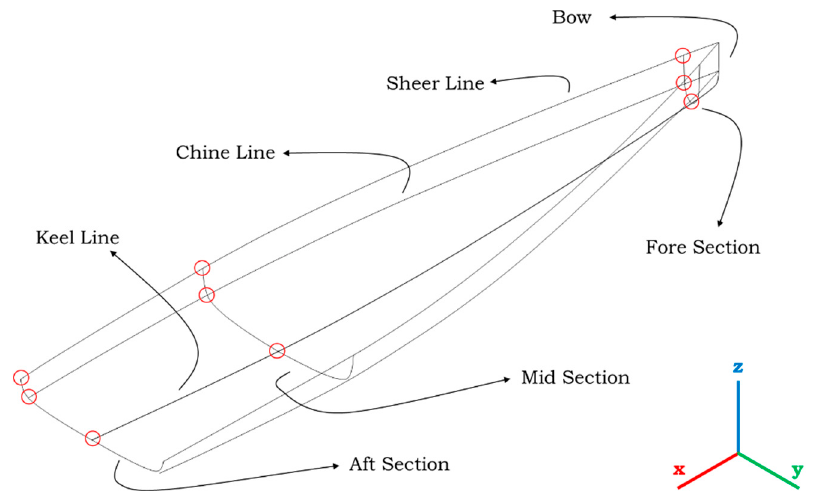
Figure 5. Curves frame used to define the hull surface.